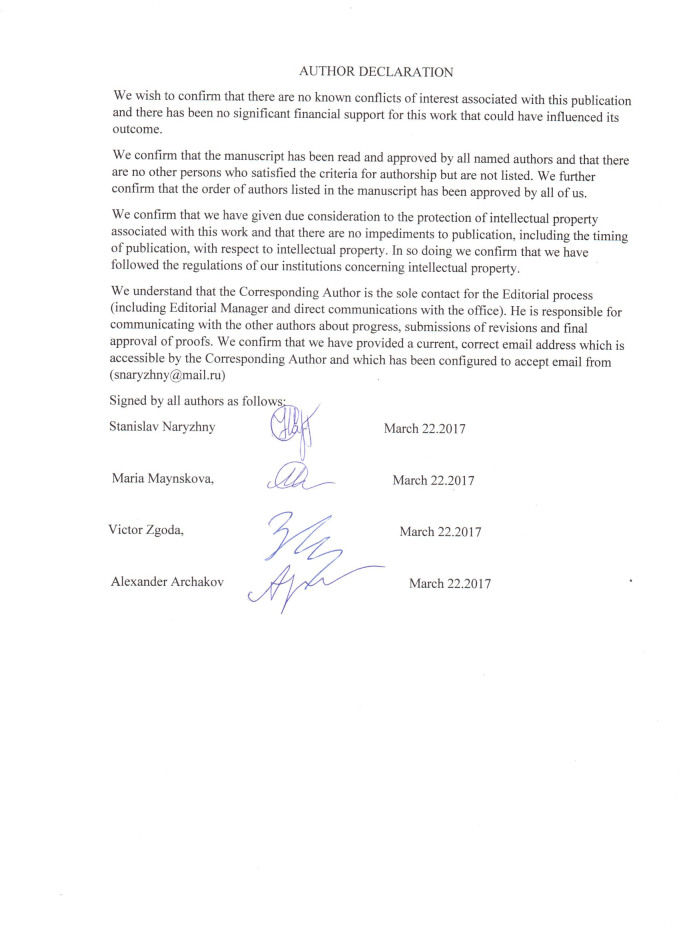
Supplementary Table 1. A list of proteins detected in extracts of the human liver or HepG2 cells by ESI LC-MS/MS using FASP protocol.